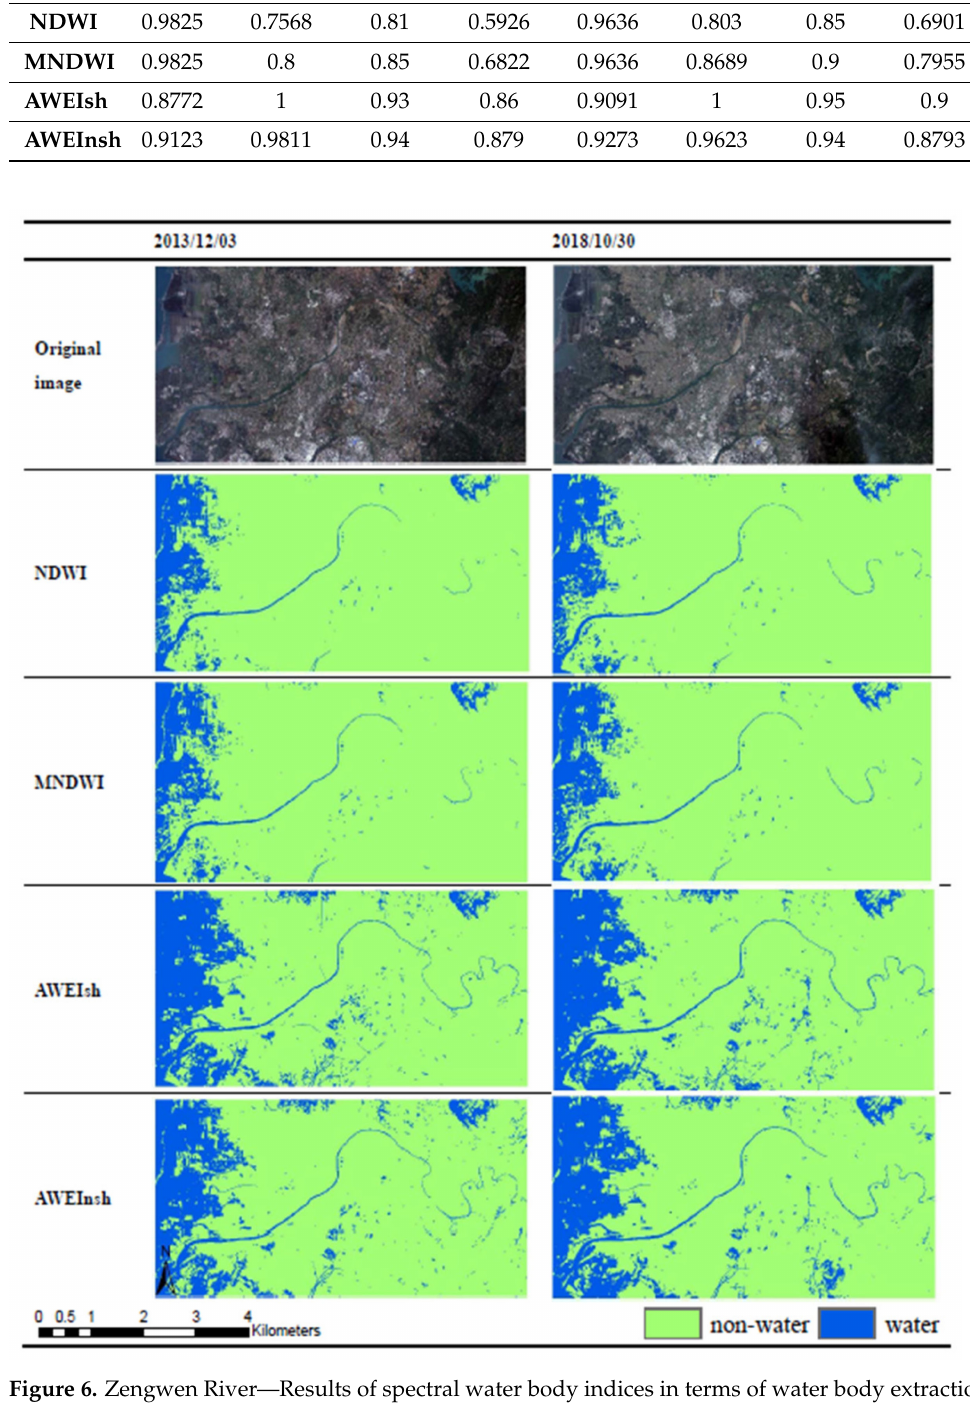
Figure 6. Zengwen River—Results of spectral water body indices in terms of water body extraction at different